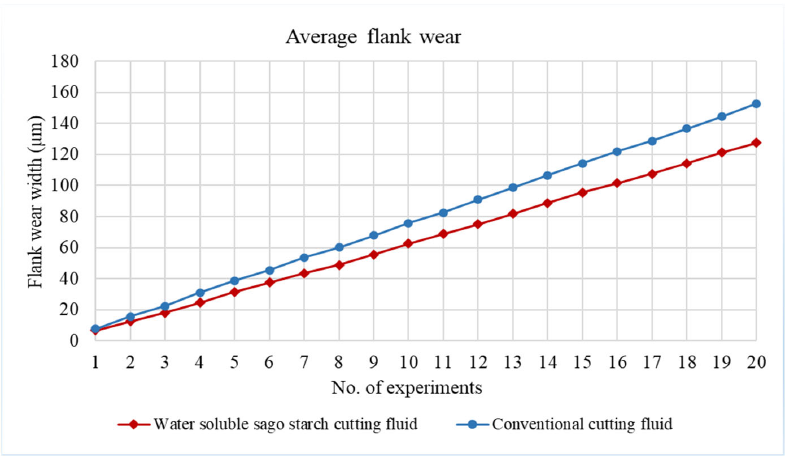
Figure 9. Average flank wear after conducting whole experiments.